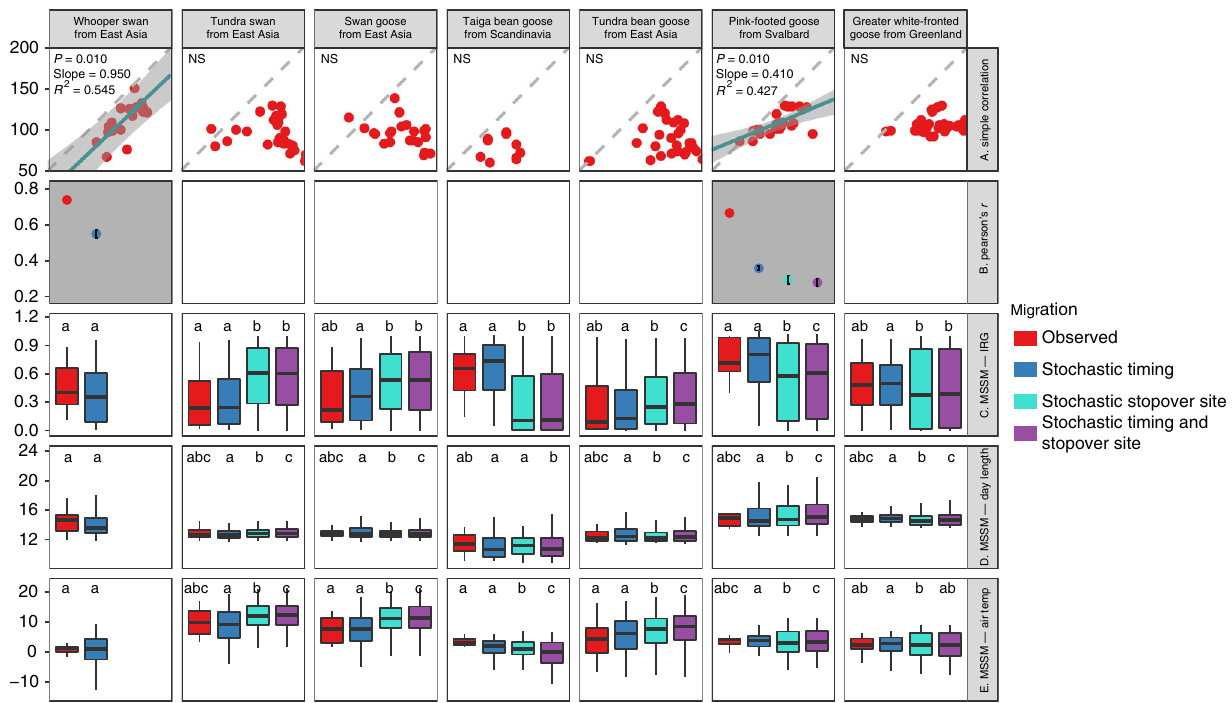
Fig. 3 Testing the green wave hypothesis for facultative herbivores by three different methods. See Fig. 2 for de fi nitions and details of panels, symbols, colours, acronyms and boxplots. For the population without available migration tracks (Whooper Swan from East Asia), only stochastic timing simulations were performed, compared and plotted. Source data are provided as a Source Data fi